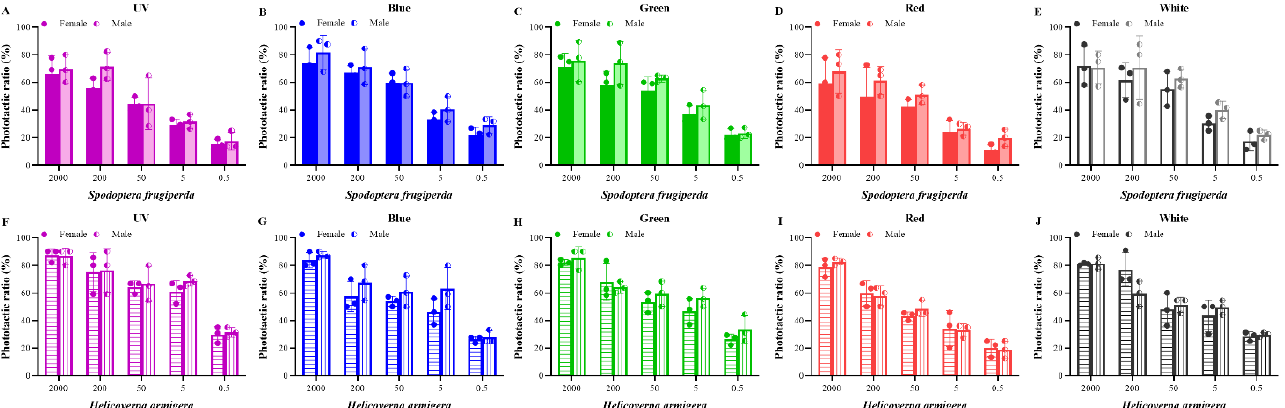
Figure 2. Phototactic rates of male and female adults of S. frugiperda and H. armigera . A-E, phototactic ratios of male and female adults of S. frugiperda to different wavelength lights under five light in- tensities (A for UV light; B for blue light; C for green light; D for red light; E for white light). F-J, phototactic ratios of male and female adults of H. armigera to different wavelength lights under five light intensities (F for UV light; G for blue light; H for green light; I for red light; J for white light). Data are mean ± SE. Means between the two groups under the same light intensity were compared according to Student’s t -test ( p < 0.05). UV, UV LED; Blue, blue LED; Green, green LED; Red, red LED; White, white LED.